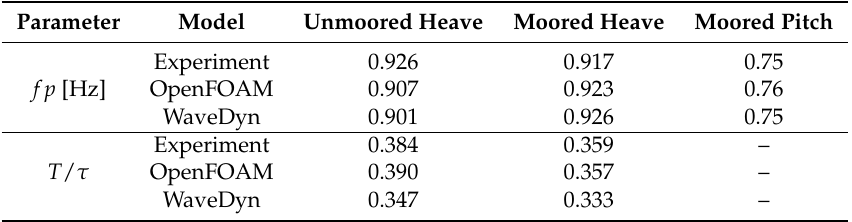
Table 6. Decay tests resonance frequencies and